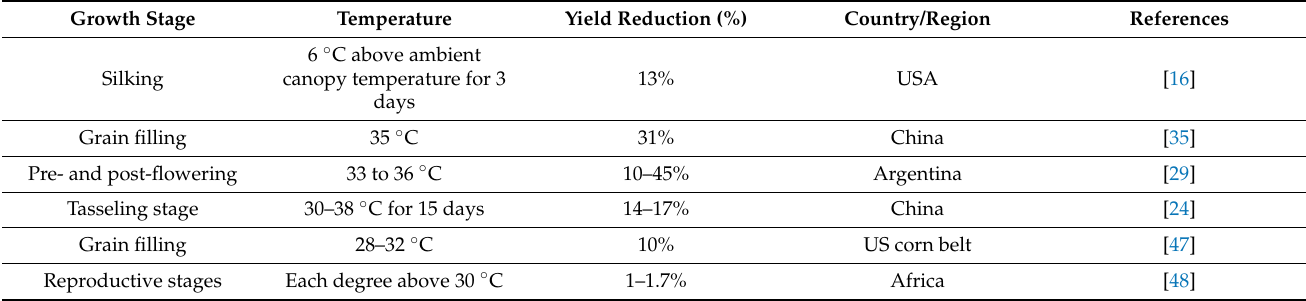
Table 2. The impacts of heat stress on maize grain